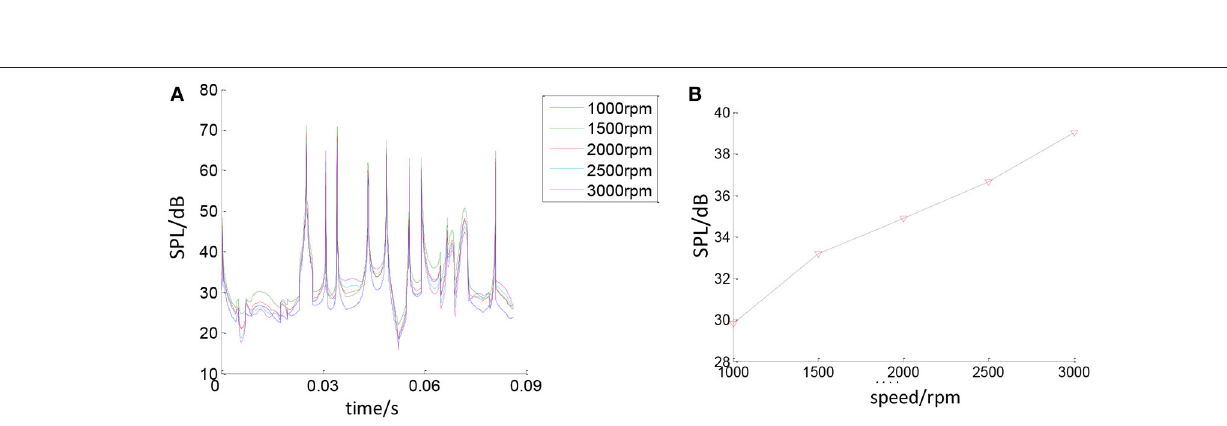
FIGURE 18 | The relationship between bearing rotating speed and bearing SPL. (A) Effect of speed on bearing SPL. (B) Effect of speed on average bearing SPL.